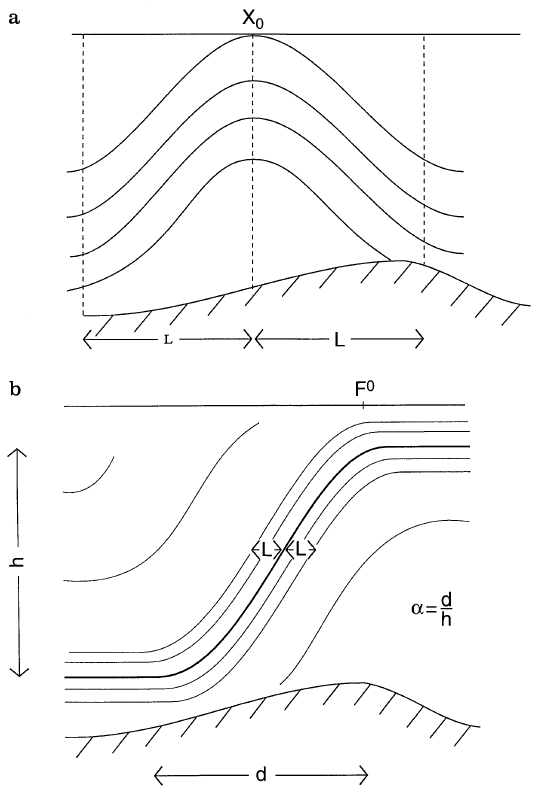
Fig. 4a, b. Schematic illustrations of feature parameters: a cold eddy, showing the centre x (cid:48) and radius ‚ , and b front, showing the surface position F (cid:48) , width ‚ , and slope (cid:97)